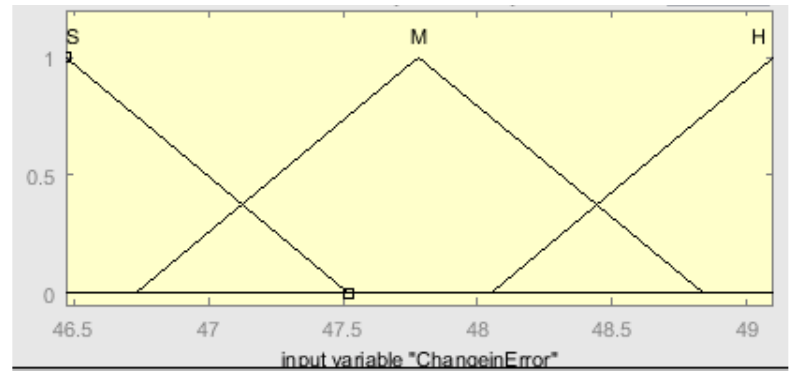
Figure 9. Membership function of input variable in terms of error.